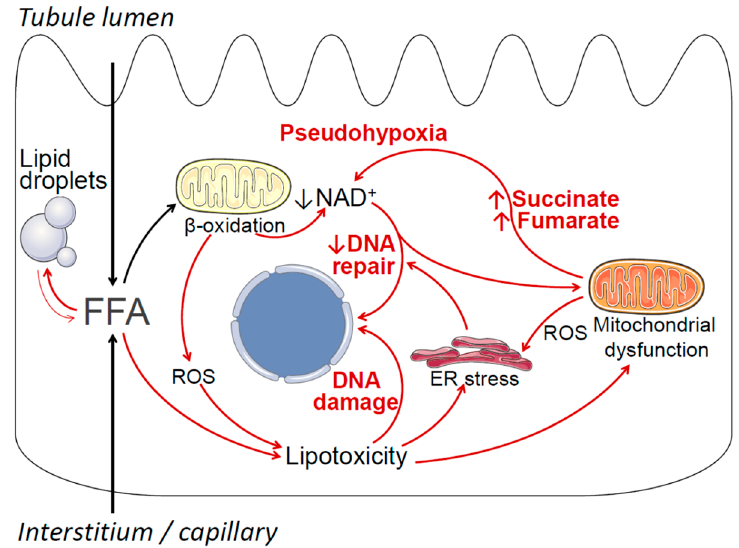
Figure 1. Summary of potential mechanisms by which obesity-related lipid metabolic disturbances in renal proximal tubule cells may contribute to cancerous cell transformation and ccRCC. Free (non-esterified) fatty acids (FFAs) enter proximal tubule cells via the basolateral side (from the circulation) and the apical side (reabsorption of albumin-bound fatty acids). Under normal conditions most FFAs are transported into the mitochondria, where they undergo beta-oxidation, thus fulfilling the proximal tubule’s large ATP requirements. Excess FFA resulting in increased beta-oxidation may deplete cellular nicotinamide adenine dinucleotide (NAD + ), resulting in a pseudohypoxic state, which in turn may lead to VHL-independent HIF activation. Declining NAD + levels may also negatively affect NAD + -dependent cellular DNA repair and DNA damage response mechanisms, including PARP enzymes and sirtuins. Increased beta-oxidation also results in increased production of reactive oxygen species (ROS). When the availability of FFAs exceeds the cells’ beta-oxidative capacity, FFAs may be stored in lipid droplets, and may also enter alternative metabolic pathways, resulting in the formation of toxic compounds, such as ceramides and diacylglycerol. These compounds, together with increased ROS, exert a variety of toxic effects collectively known as lipotoxicity, resulting in DNA damage, endoplasmic reticulum (ER) stress, and mitochondrial dysfunction. In turn, ER stress may further impair the cell’s DNA repair and DNA damage response mechanisms, and mitochondrial dysfunction may result in increased generation of pro ‐ oncogenic metabolites, such as succinate and fumarate, that contribute to pseudohypoxia.